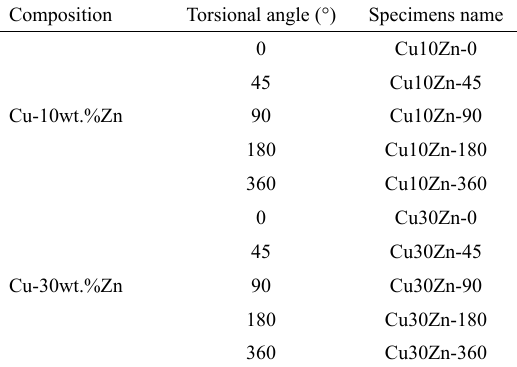
Table 1. The composition, torsional angle and corresponding specimen names of different specimens. Composition